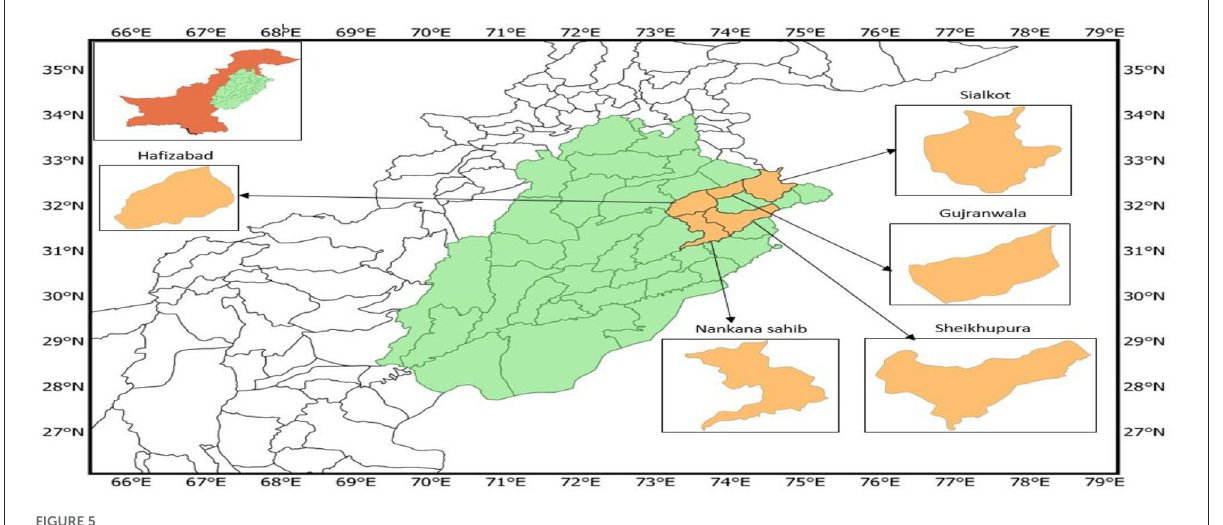
FIGURE5 Map of study location/sites in rice-wheat cropping zone of